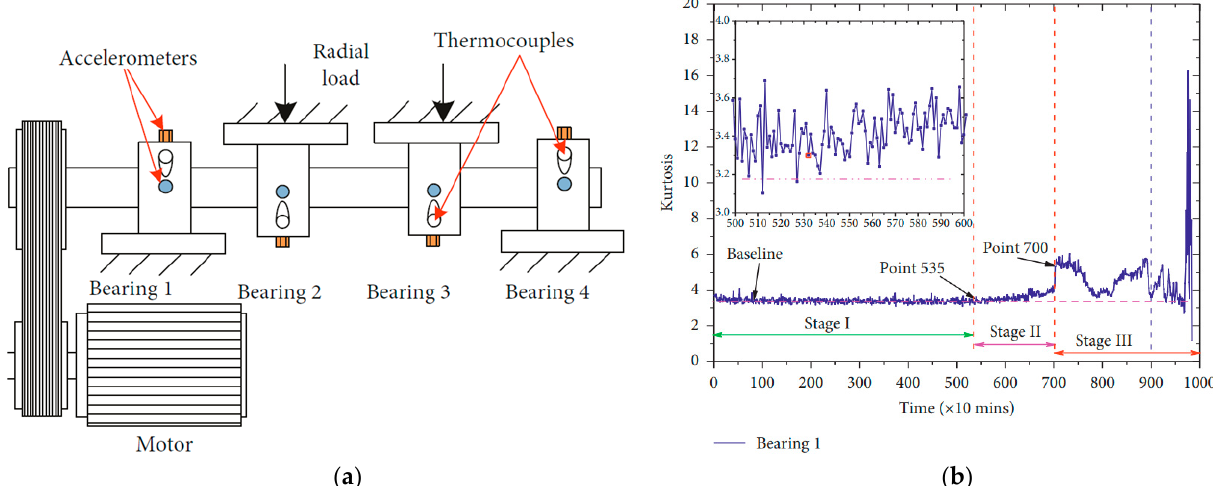
Figure 22. ( a ) Bearing test rig and ( b ) kurtosis variation of incipient bearing faults at different stages [66].